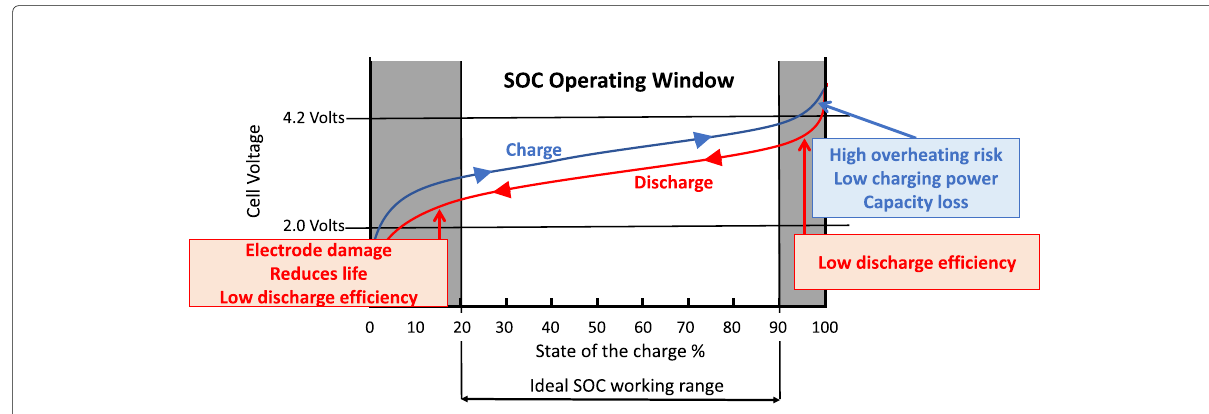
Fig. 2 Recommendations for the operating range of SOC for lithium ion battery